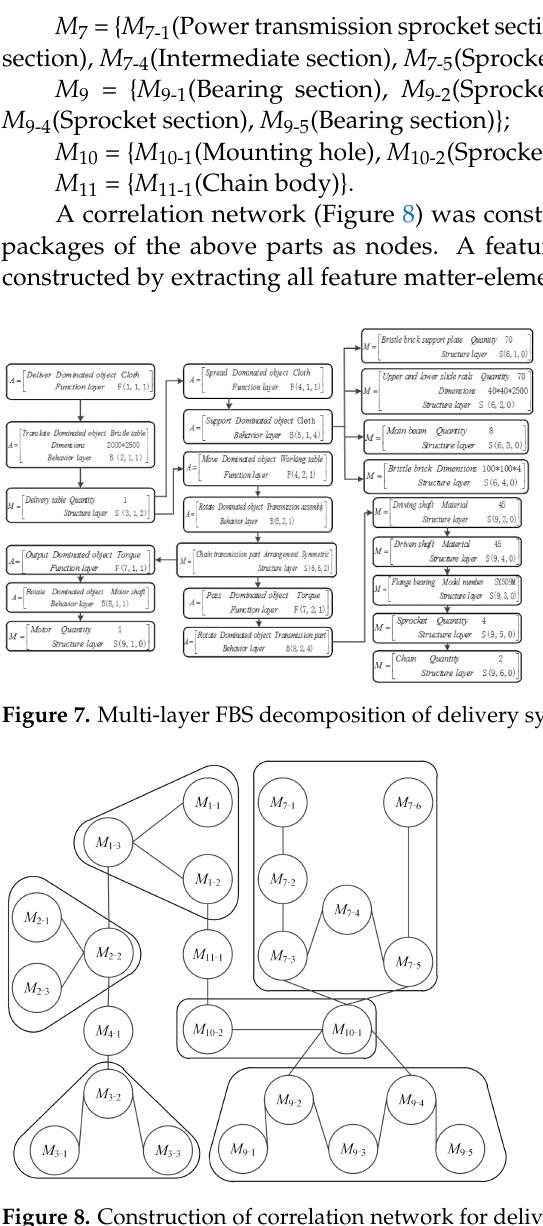
Figure 8. Construction of correlation network for delivery system of cutting machine. R = { r 1 -Dimension relationship; r 2 -Fit relationship; r 3 -Position relationship; r 4